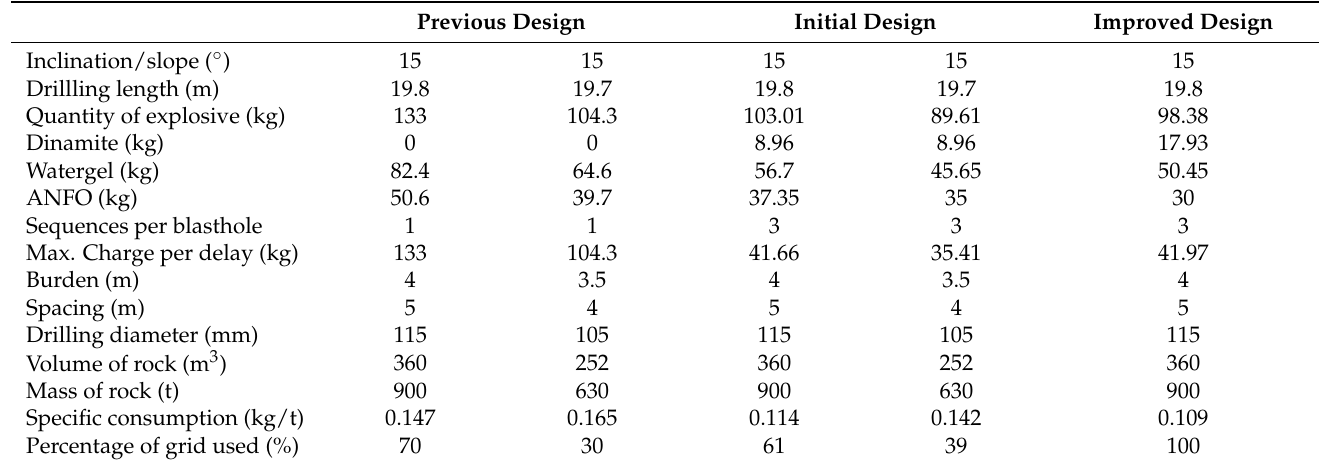
Table 1. Characteristics of the different blast designs.